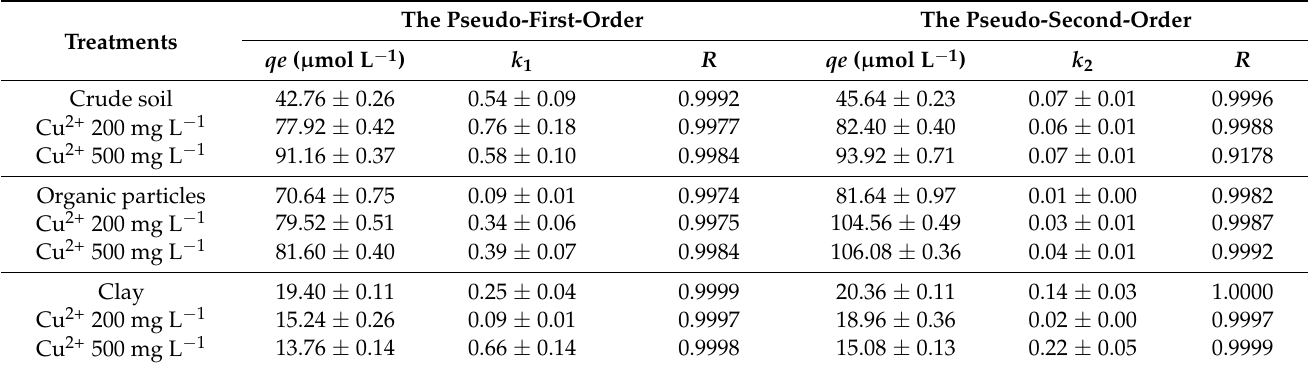
Table 5. Fitting results of the Linear and Freundlich models for adsorption curves of SDZ on soil composition (mean values ± standard error).